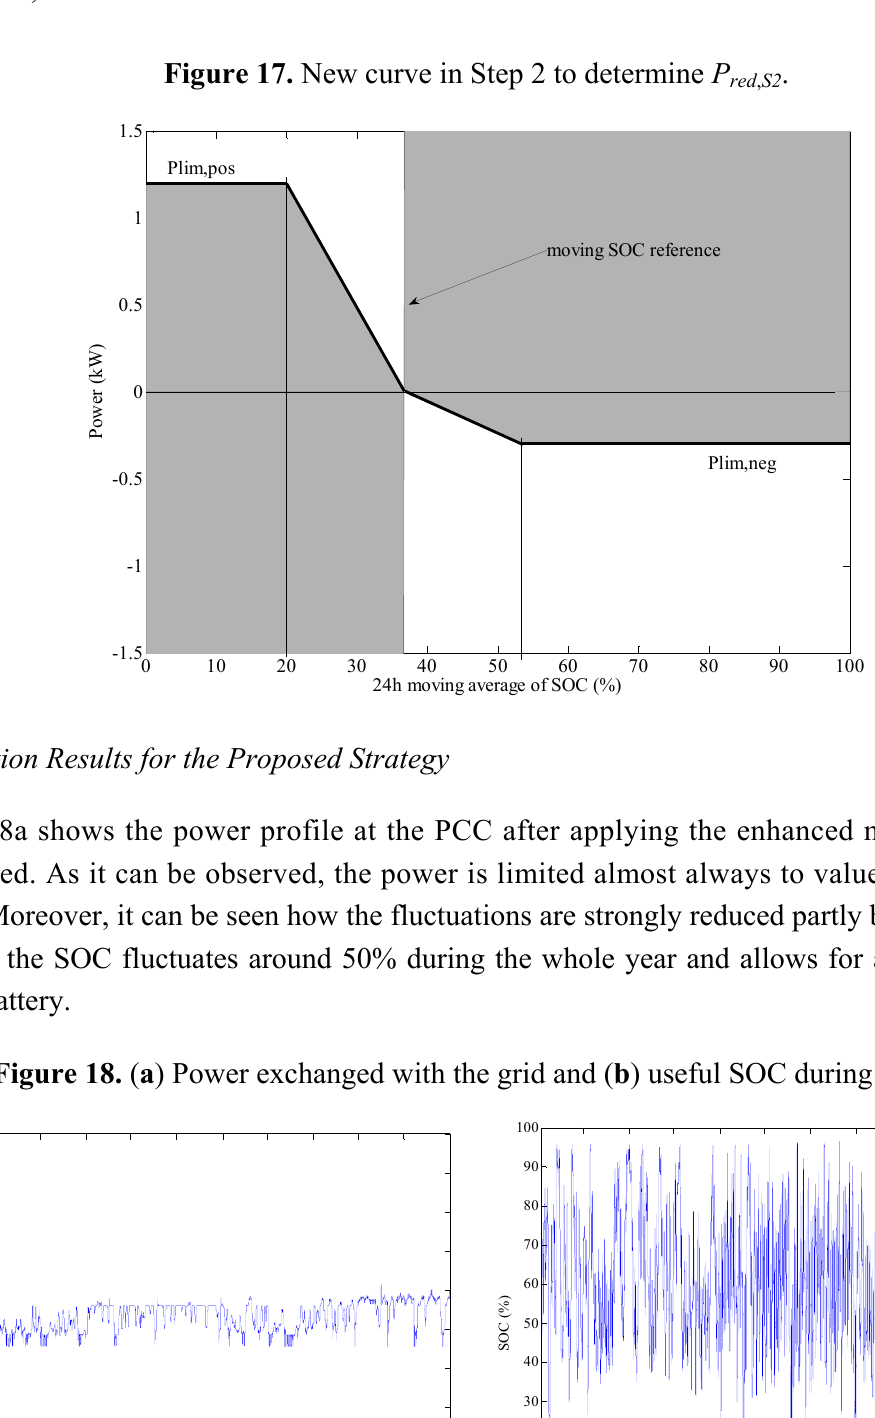
Figure 17. New curve in Step 2 to determine P